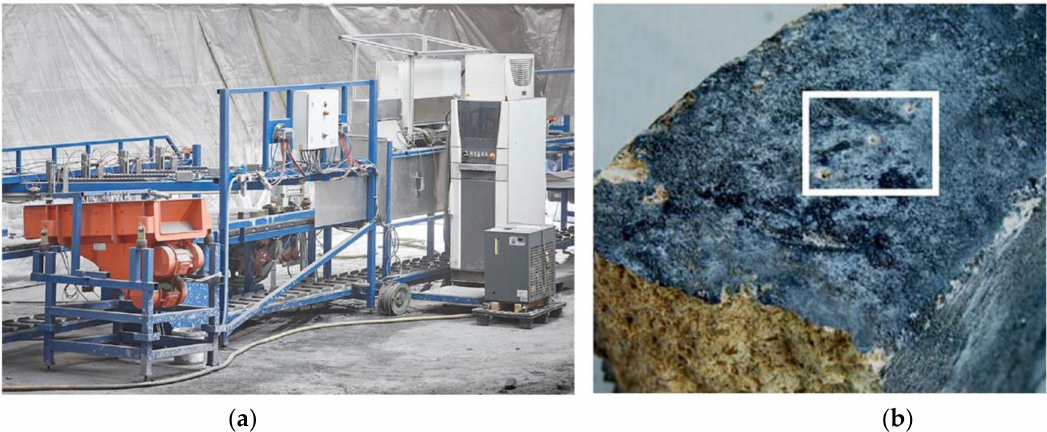
Figure 15. LIBS on-site measurement of spent refractory materials. ( a ) Demonstrator of a LIBS-based sorting machine (Photo: Orbix). Adapted from [461]. ( b ) End-of-life refractory brick with a modified surface layer. LIBS measurement spots marked with white rectangle (Photo: Fraunhofer ILT). Adapted from